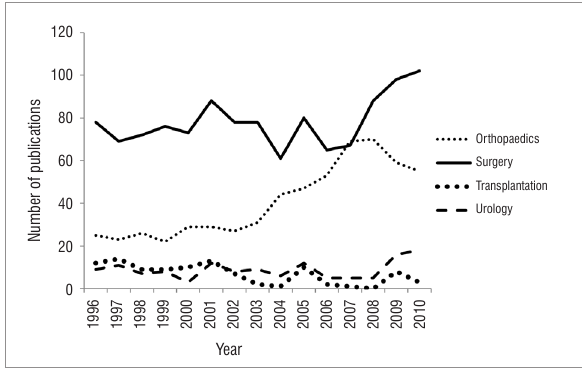
Figure 7: Number of publications from South Africa in Surgery and sur- gical specialties during 1996–2010.